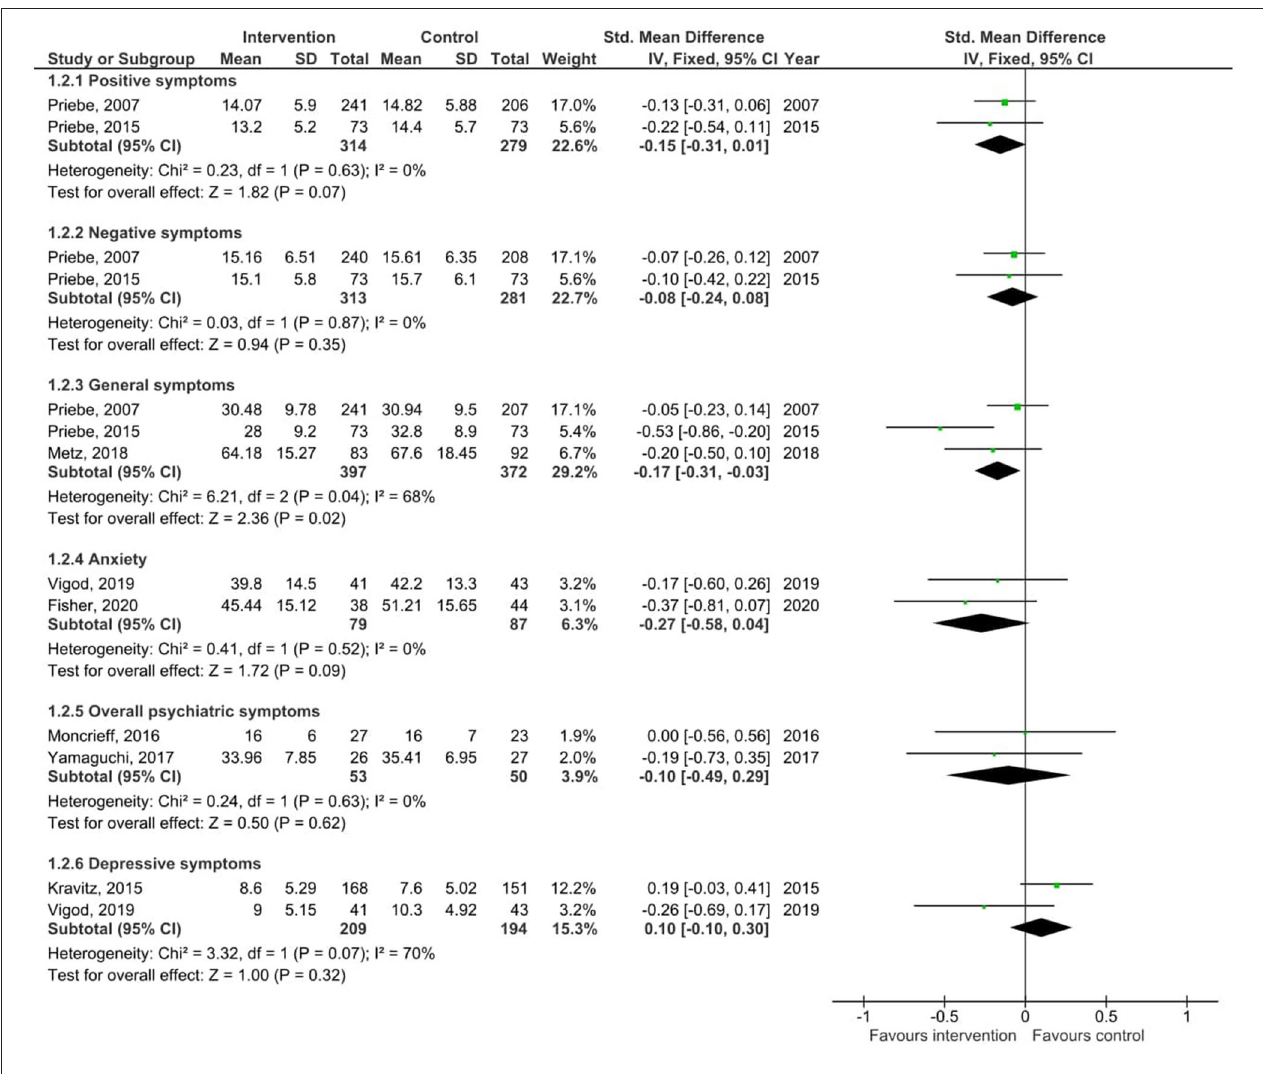
FIGURE 4 | Forest plots for symptoms.